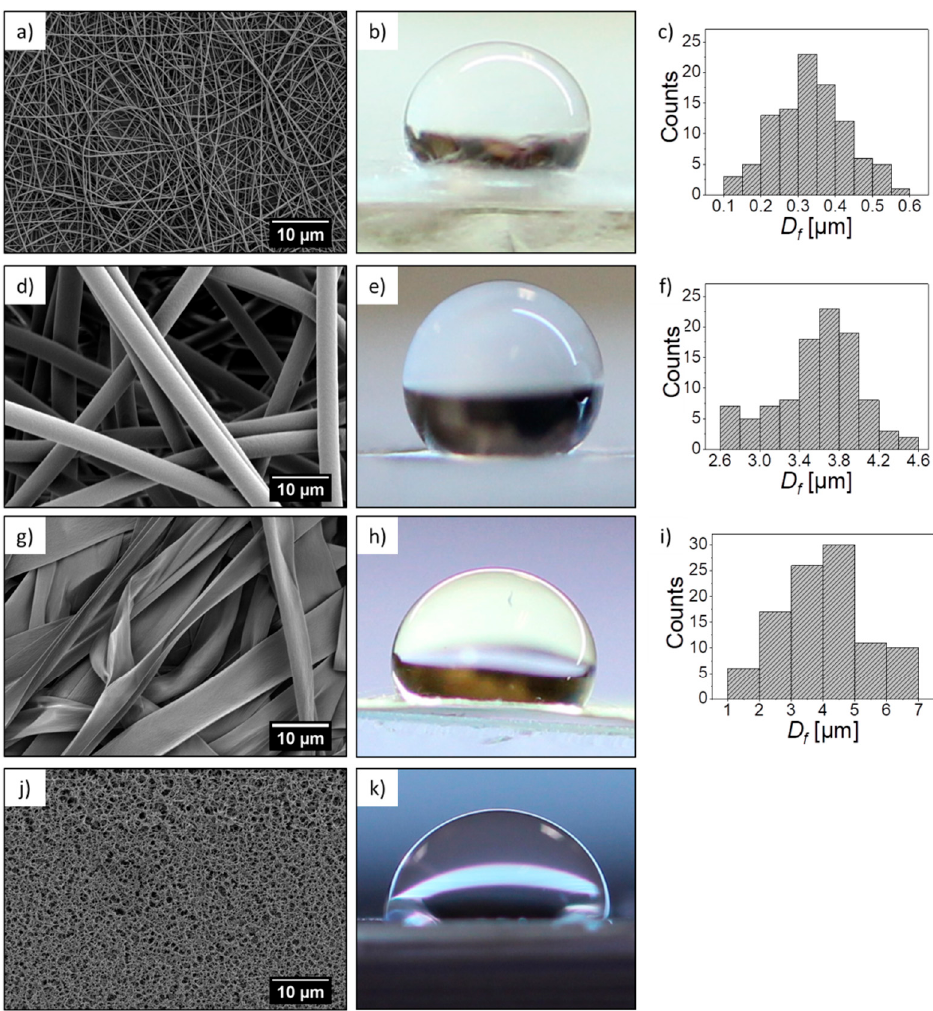
Figure 2. Poly(methyl methacrylate) (PMMA) ( a ) nanofibers, ( d ) microfibers, ( g ) ribbons, ( j ) and films SEM micrographs, and their corresponding representative images of the water droplet used for contact angle measurement ( b , e , h , k ), respectively, and ( c , f , i ) histograms showing the diameter of the fiber size distribution. Table 2. The summary of all measurements performed on the PMMA samples and cells, including the average diameter of fiber ( D f ), average roughness ( R a ), the average distance between fibers ( S f ), and the water contact angle ( Ɵ ), on all PMMA surfaces; and the filopodia length, after 3 days of cell culture ( L c ).